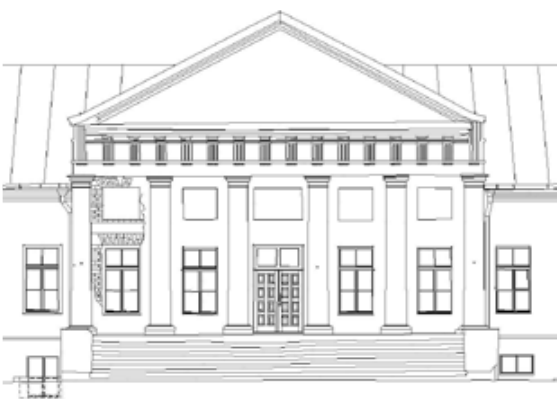
Fig. 6. 2D drawing of the central part of the Arnionys mansion-house façade using photogrammetric data